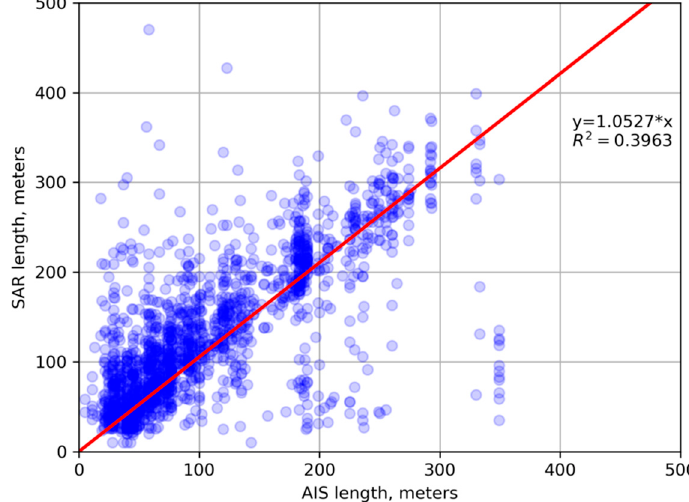
Figure 18. A comparison of vessel length reported by AIS vs. estimated from Sentinel-1 SAR data.